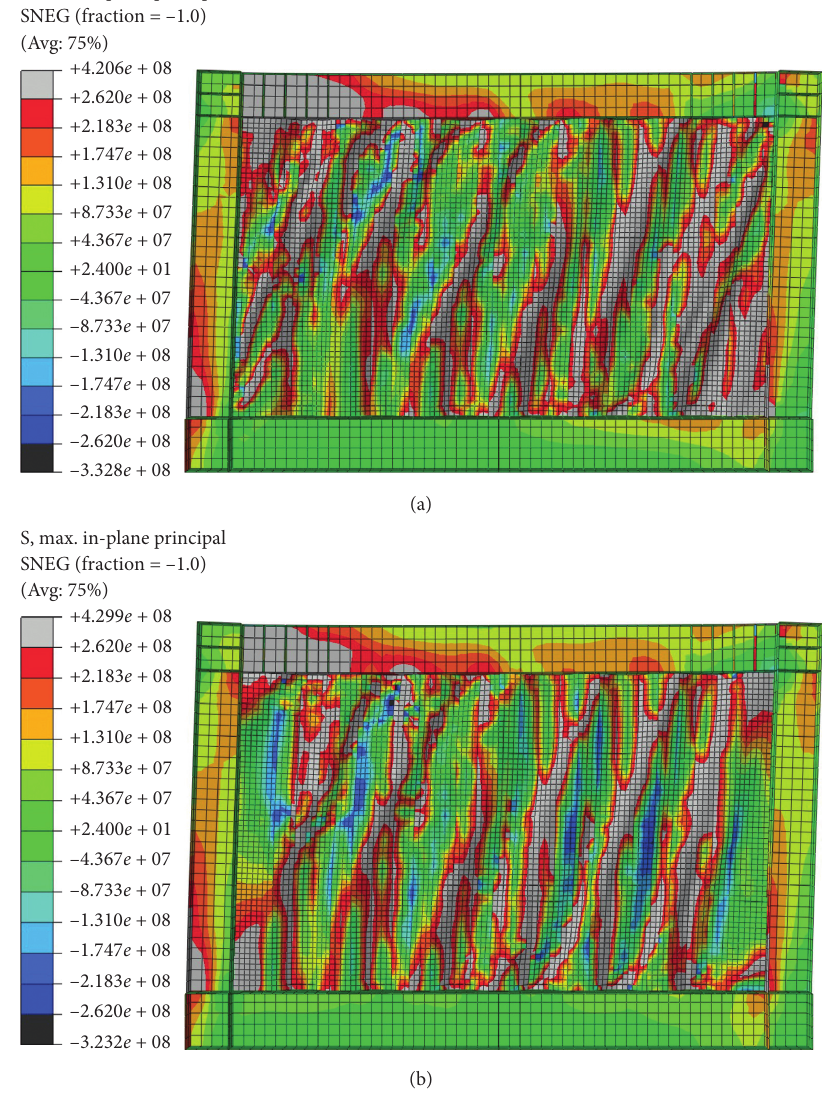
Figure 12: Maximum in-plane principal stress contours in V-CSPSW. (a) Fully connected V-CSPSW. (b) Beam-only-connected